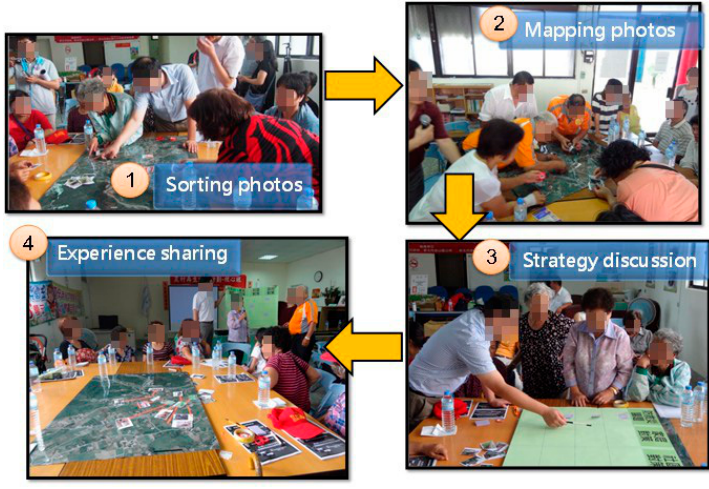
Figure 2. Strategy Development Process.